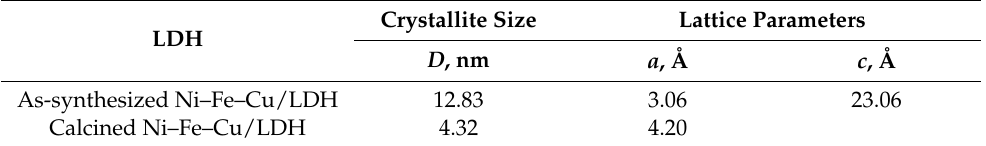
Table 5. Crystallite size and lattice parameters of as-synthesized and calcinated Ni–Fe–Cu/LDH. Crystallite LDH